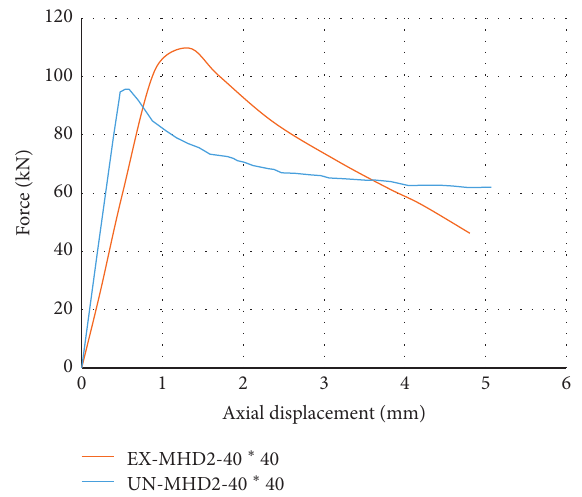
Figure 5: Force-displacement diagram of model and laboratory sample.